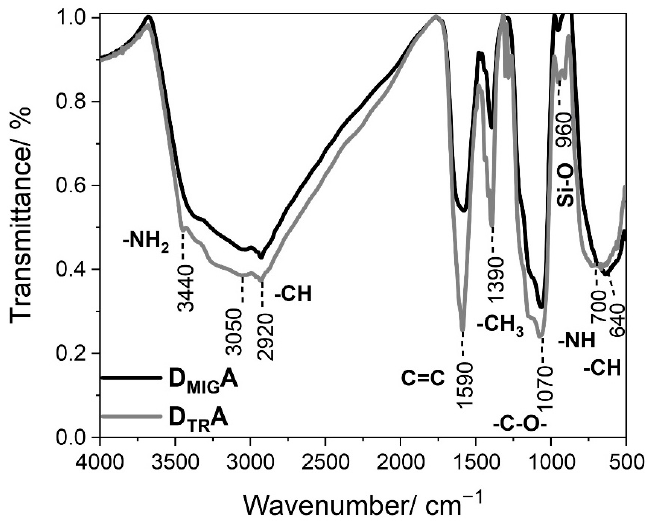
Figure 2. Fourier transform infrared spectra of TiO 2 @SiO 2 -(CH 2 ) 3 -NH-R101/110 with a different ratio of the donor (D—rhodamine 110 chloride) to acceptor (A—rhodamine 101).